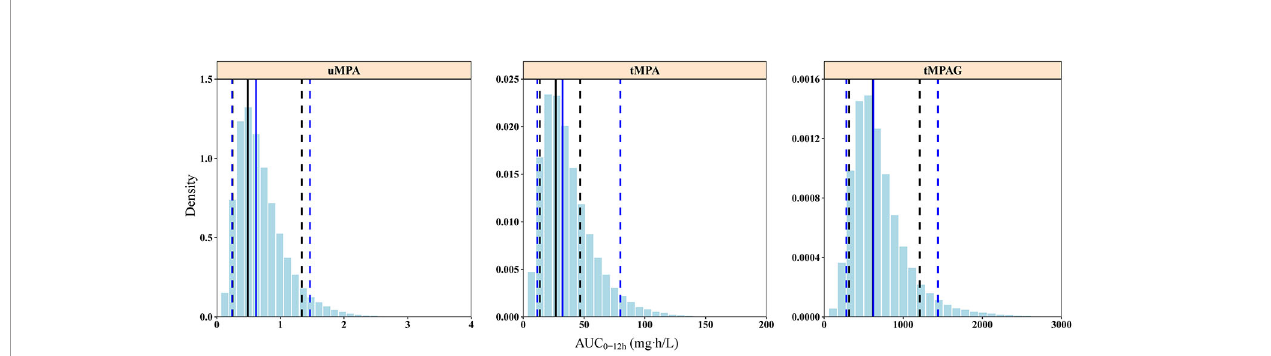
FIGURE 4 | Posterior predictive check graphics of fi nal model for uMPA, tMPA, and tMPAG. The histograms represent the distribution of simulations. Black and blue solid lines represent the medians of observations and simulations, respectively. The observed 5th and 95th percentiles are presented by black dashed lines, and the simulated 5th and 95th percentiles are presented by blue dashed lines. The simulated AUC 0 – 12h values present good consistency with observations. In particular, the 5th percentiles of simulations and observations for uMPA, as well as the medians of simulations and observations for tMPAG, are completely overlapped in the graphics. AUC 0 – 12h , area under the concentration – time curve within 12-h dose-interval; tMPA, total mycophenolic acid (MPA); tMPAG, total 7-O-mycophenolic acid glucuronide; uMPA, unbound